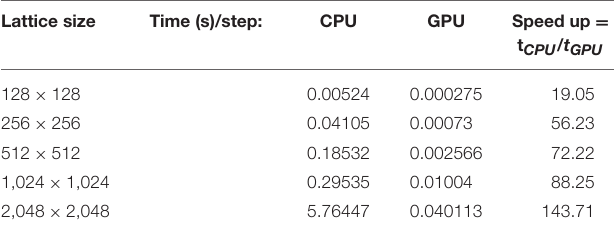
TABLE 7 | MRT-LBM simulation time in CPU and GPU for different mesh arrangements. Lattice